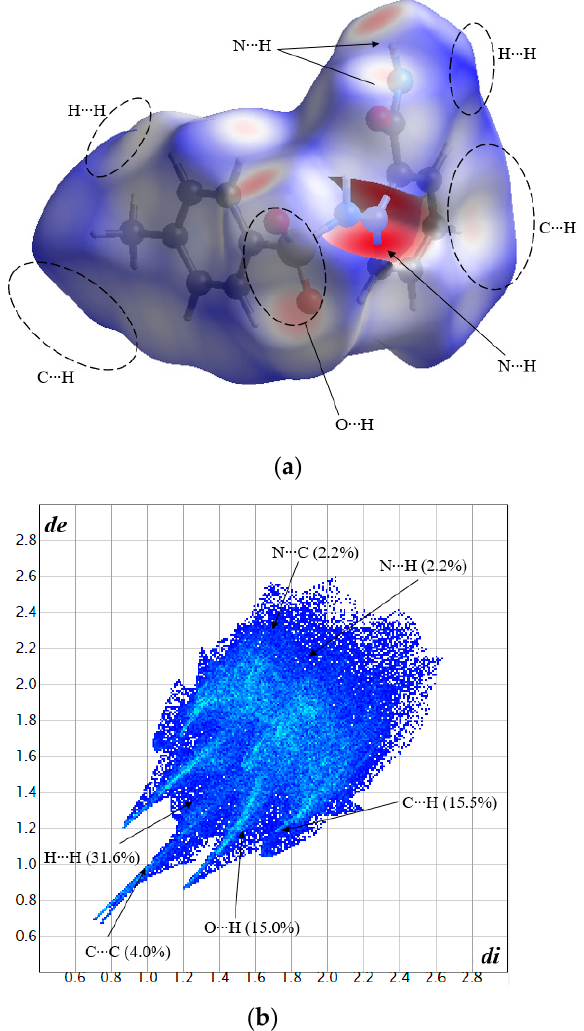
Figure 3. Hirshfeld surface for the crystal structure ( a ) and 2D fingerprint plot analysis ( b ) of 2a .